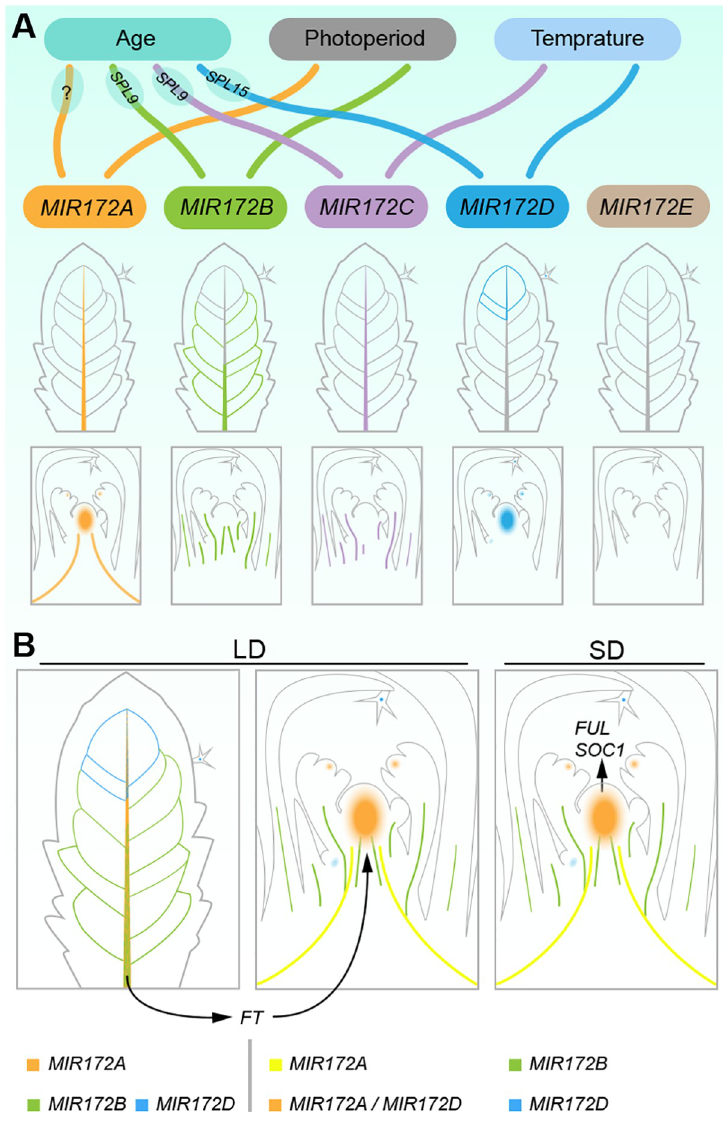
Fig 8. Distinct expression pattern and different responsiveness of MIR172 genes to plant age, ambient temperature, and photoperiod. (A) Schematic of the expression pattern of MIR172 genes. Individual MIR172 gene is shown in different color. Two SPL / MIR172 pairs (SPL9- MIR172B / C and SPL15- MIR172D ) contribute to the acquisition of floral competence in leaf vascular tissue and shoot apex, respectively. (B) Mode of MIR172 genes in regulating flowering time in LD and SD. Different combinations of MIR172 genes are shown in different colors. In LD, the products of FT move from leaves to shoot apex (black lines). FT , FLOWERING LOCUS T ; FUL , FRUITFULL ; LD, long days; SD, short days; SOC1 , SUPPRESSOR OF OVEREXPRESSION OF CO 1